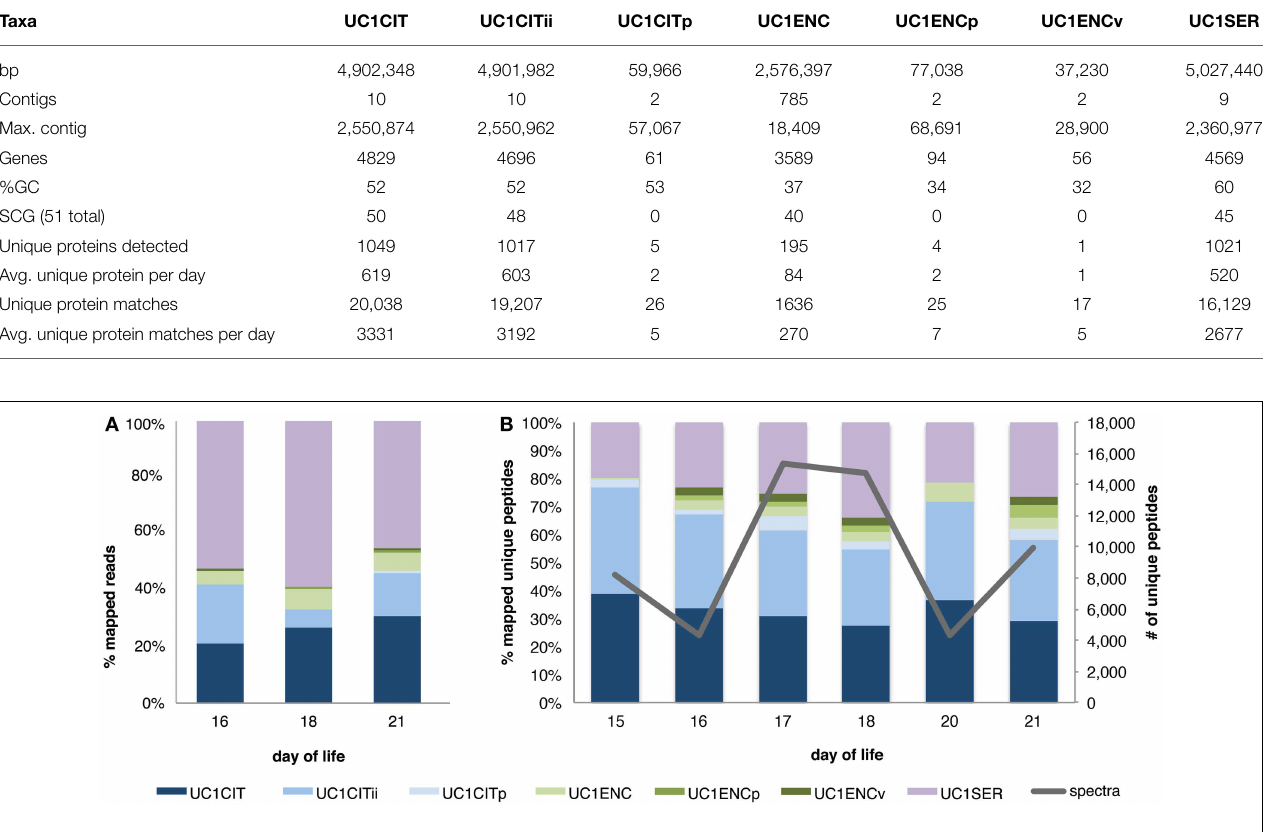
FIGURE 1 | Microbial community composition observed via read and peptide mapping. Relative proportion of reads (A) and unique peptides (spectral counts normalized by protein length and number of proteins per genome for each sample) (B) mapped to a database of metagenomes derived from dominant gut colonizers in a preterm